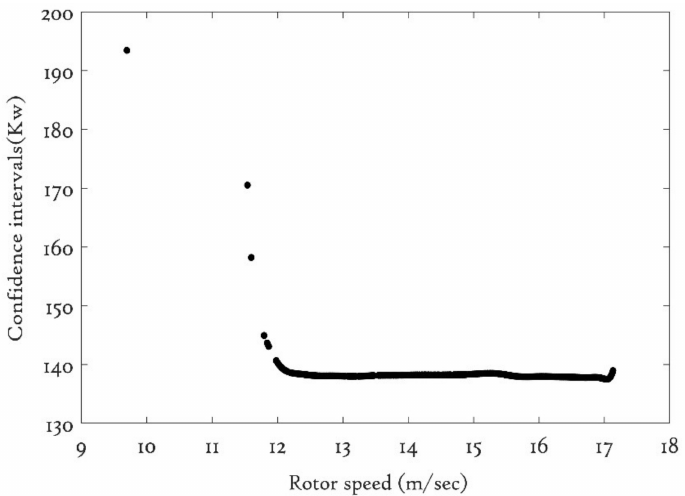
Figure 16. GP rotor power curve